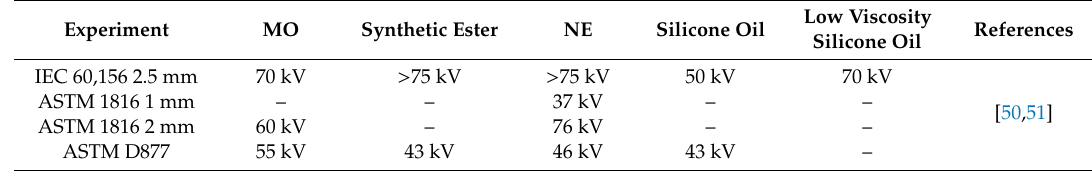
Comparison of alternating-current breakdown strengths (AC BDVs) for di ff erent insulating